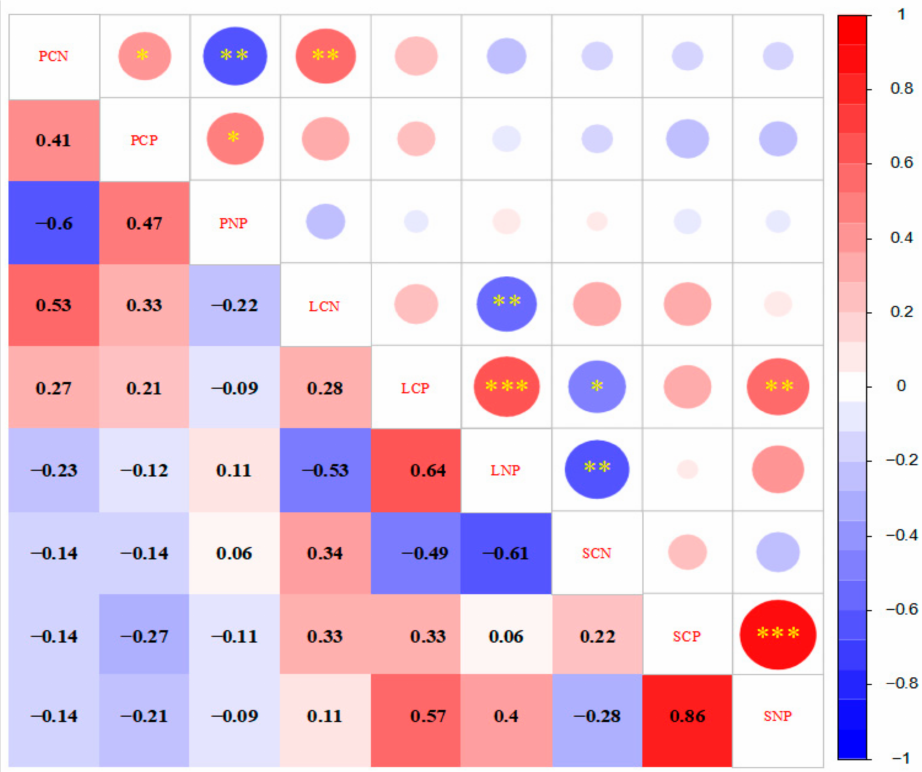
Figure 2. Correlations of C:N, C:P and N:P among leaf, litter and soil. Note: PCN: Plant C:N;